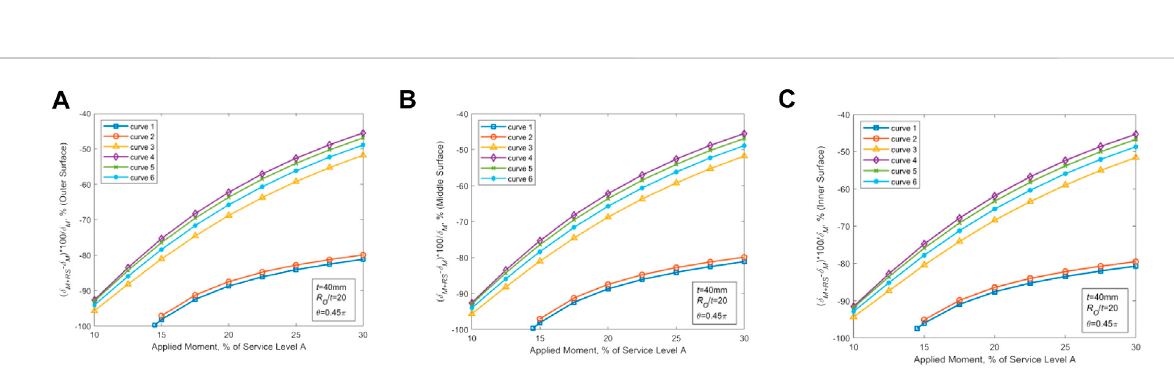
FIGURE 8 Effect of WRS on COD in various positions of the thick-walled piping with different material properties. (A) Changes in COD at the outer wall point (B) Changes in COD at the midpoints. (C) Changes in COD at the inner wall